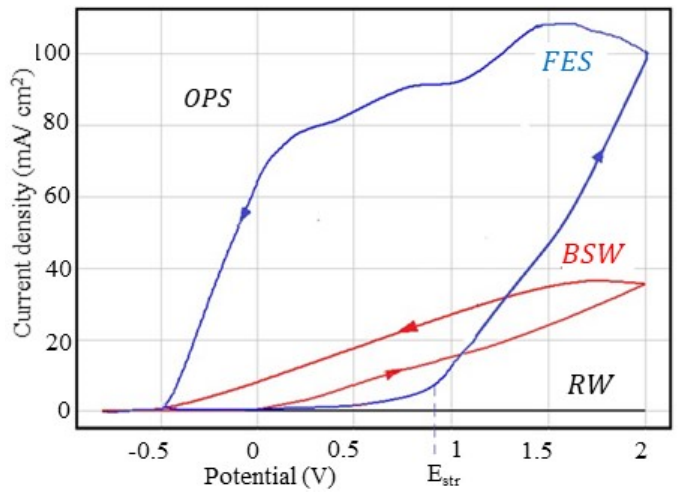
Figure 5. Cyclic voltammograms for the OPS sample. Table 13. Stimulated corrosion parameters for the C45 steel phosphate in zinc-based solution and immersed in MoS 2 lubricant sample (OPS) in the three corrosion environments.